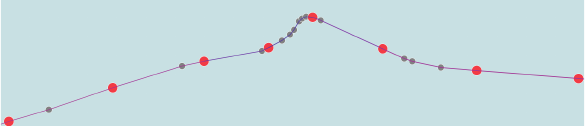
Figure 5 . Example of resampled fragments ends (red) versus raw geopoints (grey). Resampled fragments are more homogenous along the vessel